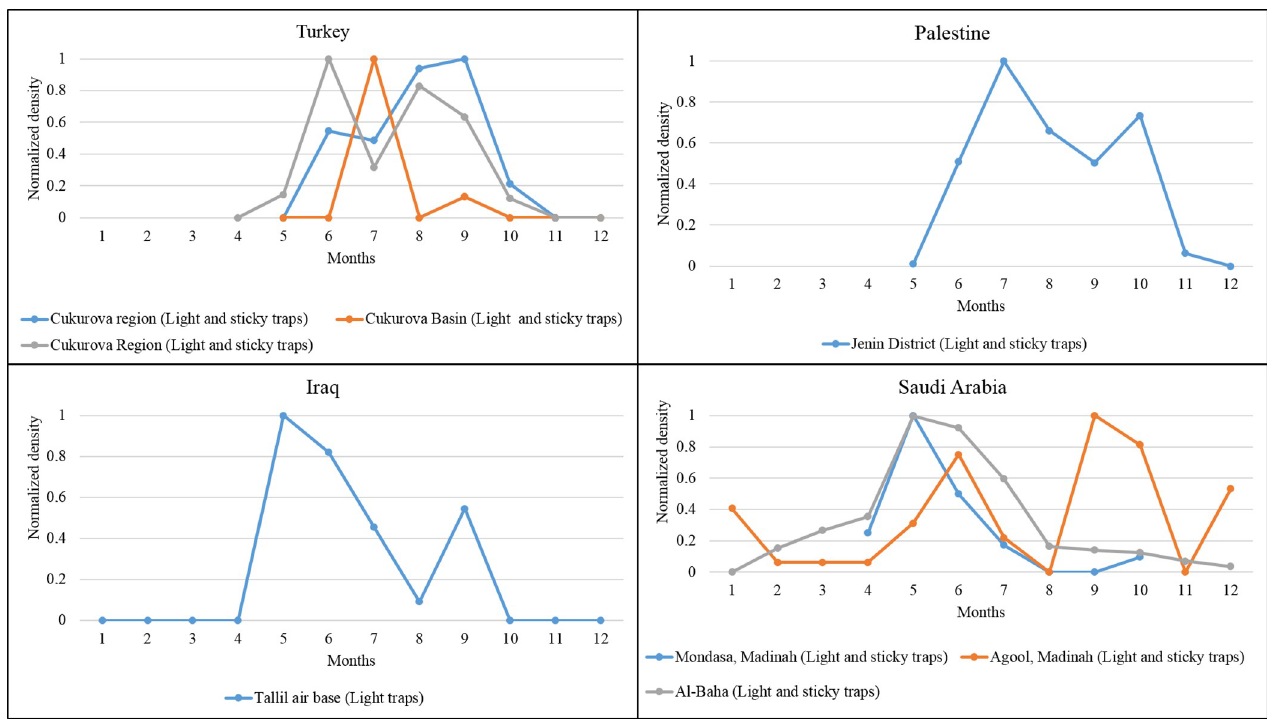
Fig 6. Seasonal P . (Par . ) sergenti density (normalized values) extracted for western Asian countries (Turkey, Iraq, Saudi Arabia, Palestine), as revealed by our meta-analysis. Data collected from different studies performed in the same locality are grouped in the same figure. Southern Asia . Data on the seasonal activity of P . (Par . ) sergenti were gathered from various geographic areas with indoor or outdoor sampling (Fig 7).